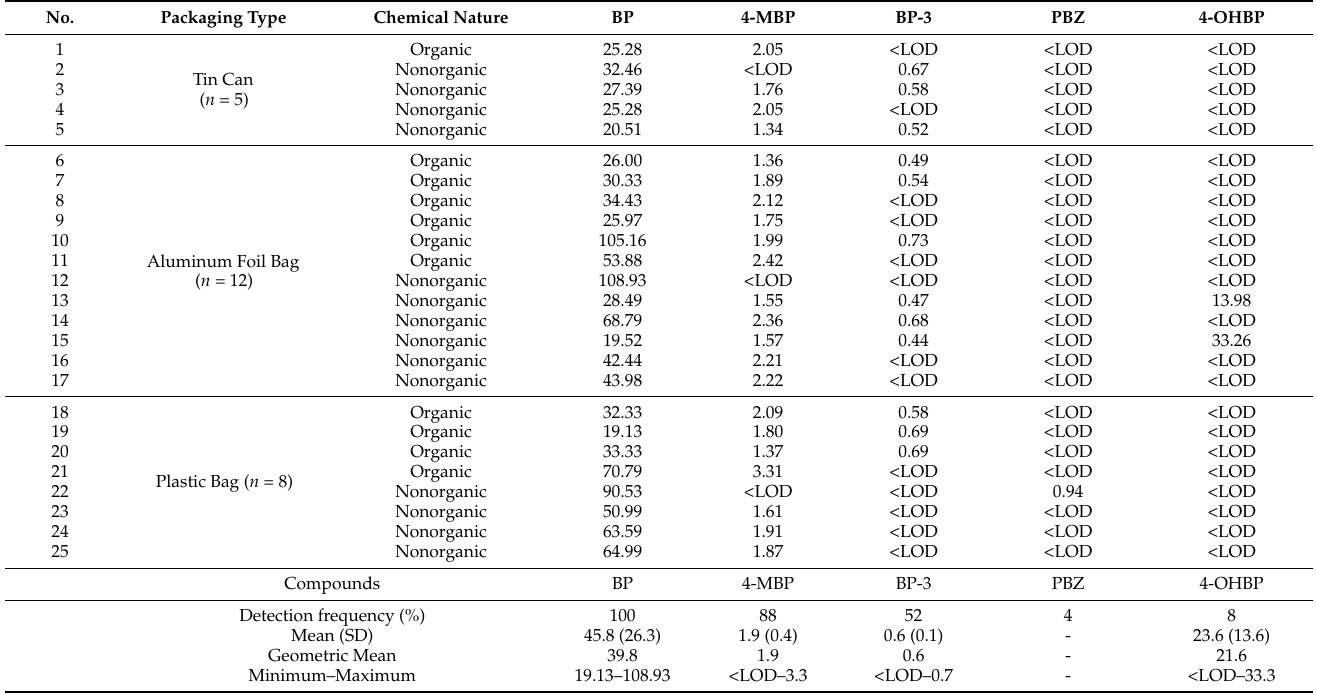
Table 3. The BP and BP analog levels in domestic samples of rice cereals grouped by packaging material and chemical nature ( n = 25)